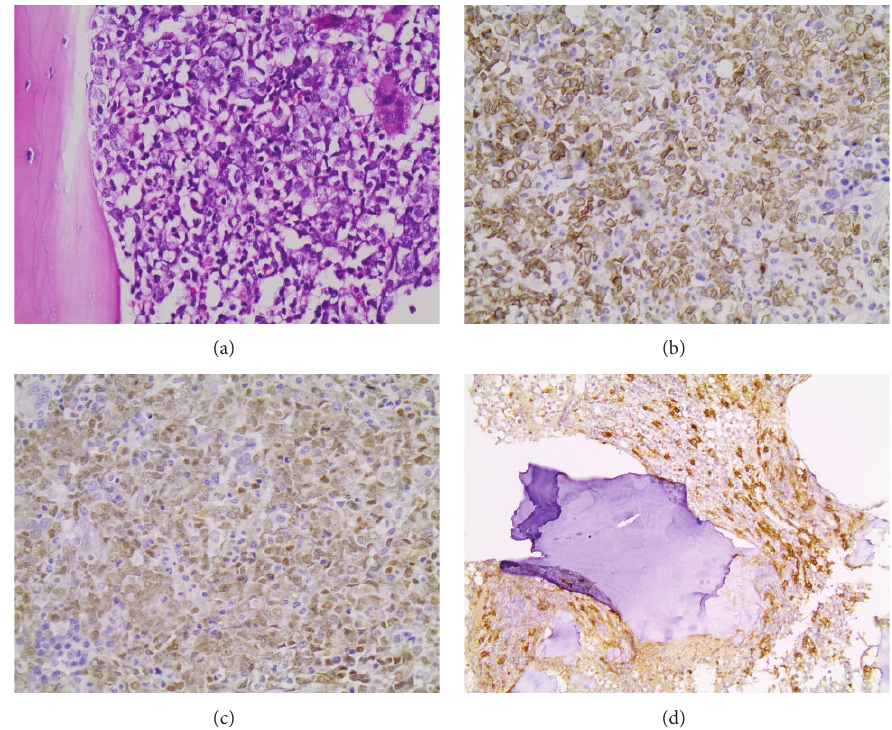
Figure 1: Initial bone marrow trephine biopsy showing infiltration by an immature blastoid population in H&E stain (a), which immunohistochemically was positive for CD79a (b) and TDT (c). The presence of a small aggregate consisting of spindle shaped mast cells is also illustrated